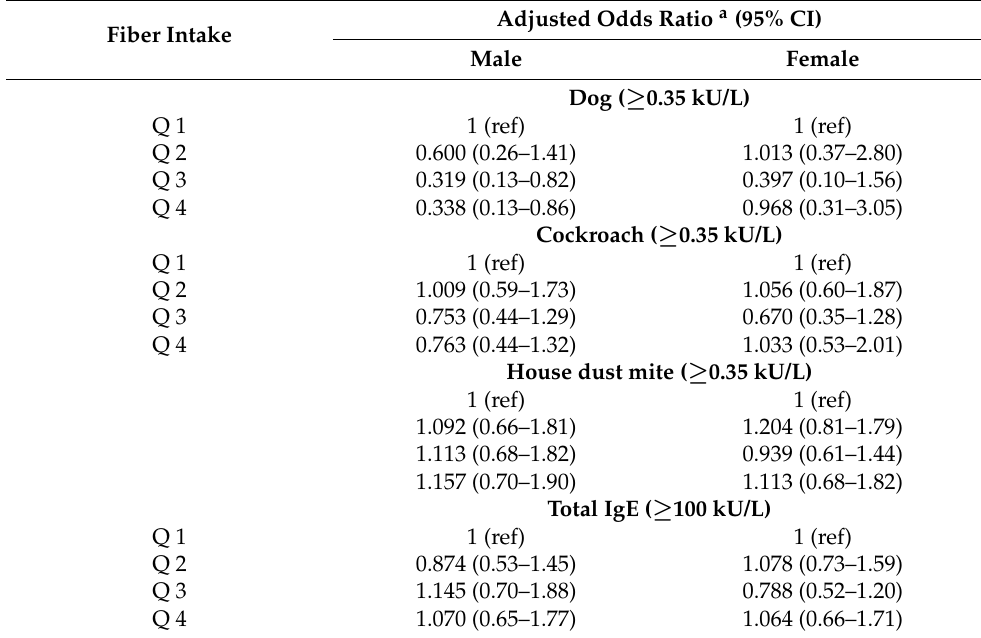
Table 6. Logistic regression analysis of the association between fiber intake and serum immunoglob- ulin E (IgE)